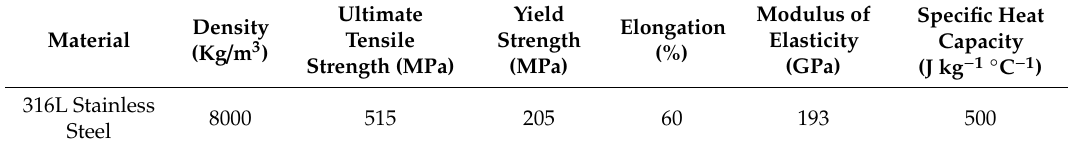
Table 2. The descriptions of the considered variables in heat convection.